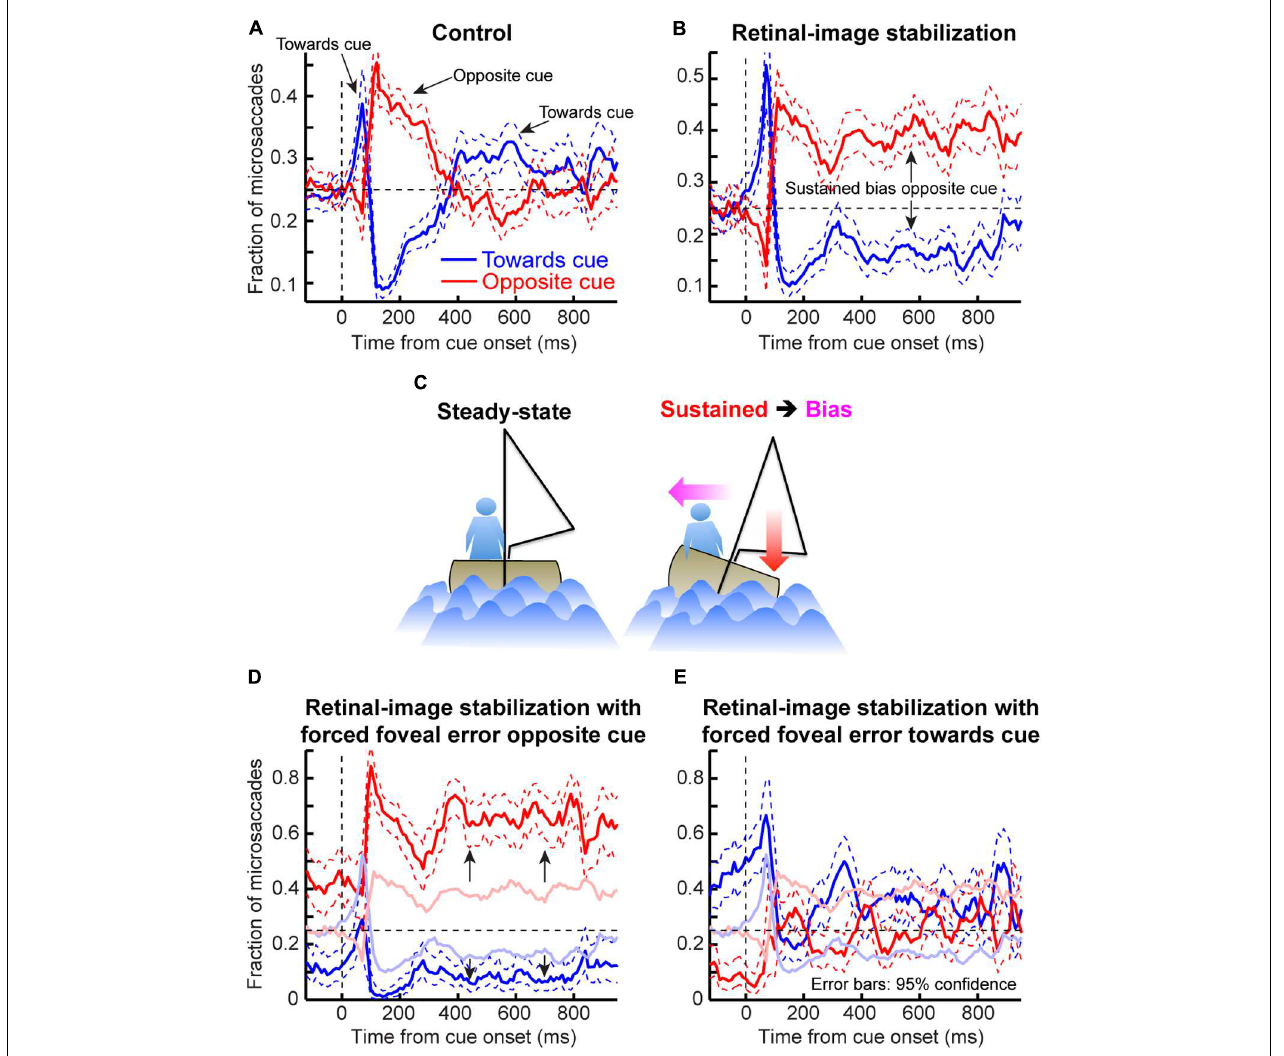
FIGURE 12 | Disrupting post-cue microsaccade direction oscillations by simply controlling foveal motor error. (A) Microsaccade directions in the control condition (repeated from Figure 10B to facilitate comparison to the other panels). (B) With retinal-image stabilization, after the initial cue-directed “escapes,” microsaccades became constantly biased opposite the cue. This is analogous to a disturbed “fixation balance” (Goffart et al., 2012). A persistent peripheral cue causes an imbalance in the oculomotor system that is rebalanced if persistent saccades are generated in the opposite direction. (C) Analogy explaining (B) and the idea of fixation balance (Goffart et al., 2012). A sustained, not transient, wind results in a sustained sailor bias. Note that this is an exacerbation of the preferred retinal locus bias away from the cue that we saw after cue onset in the control condition of Figure 10C ( t = 500 and 700 ms from cue) and Figure 11D (see Results). (D,E) Similar to (B) but when forcing the fixation spot ∼ 2.7 (cid:48) away from gaze [either opposite the cue (D) or toward it (E) ]. Microsaccade direction was strongly influenced by foveal motor error, and in all cases, the control oscillations were disrupted. Thus, oscillations in microsaccade directions after cue onset reflect optimization of eye position during fixation. The faint colors are those in (B) but included to facilitate comparison. Error bars denote 95% confidence